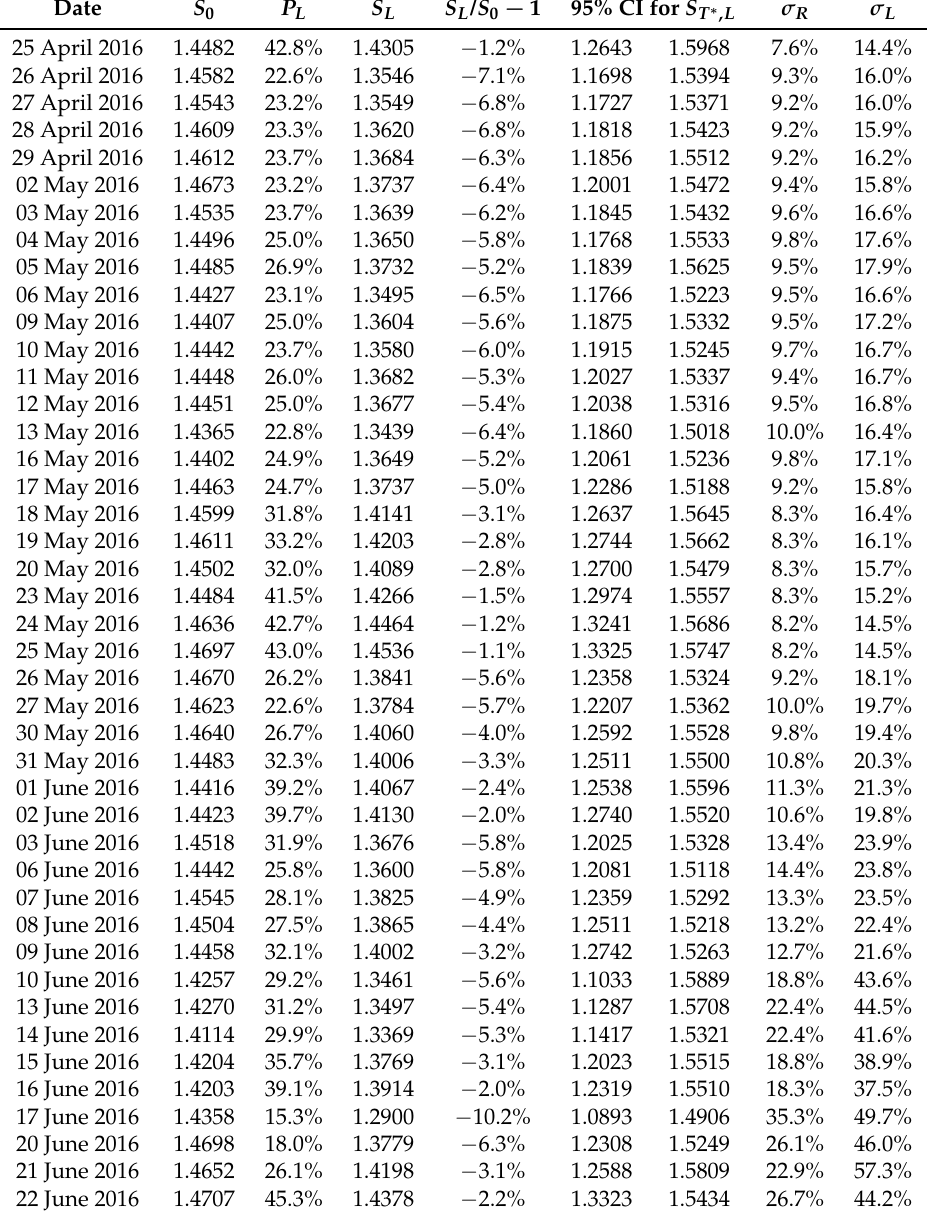
Table 2. Calibrated mixture model parameters from 25 April to 22 June